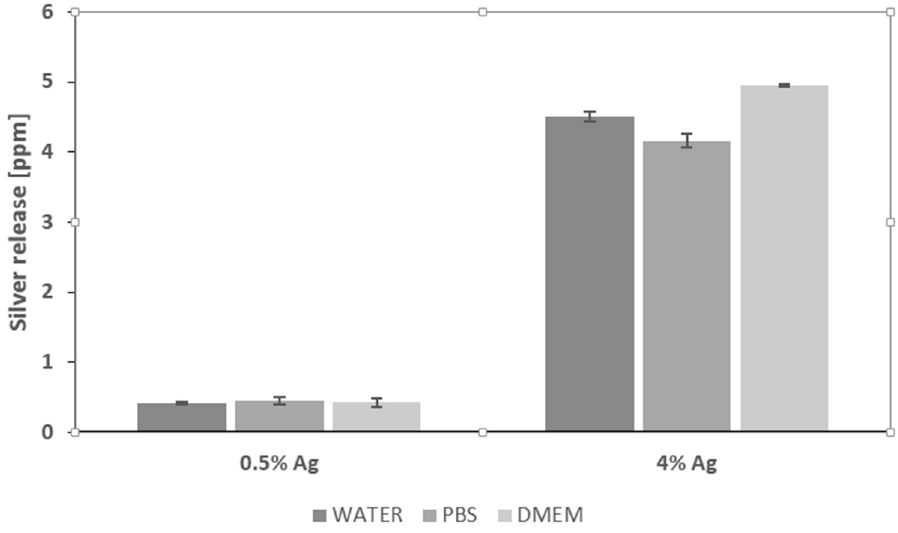
Figure 8. ICP-MS analysis performed in water, PBS and DMEM.